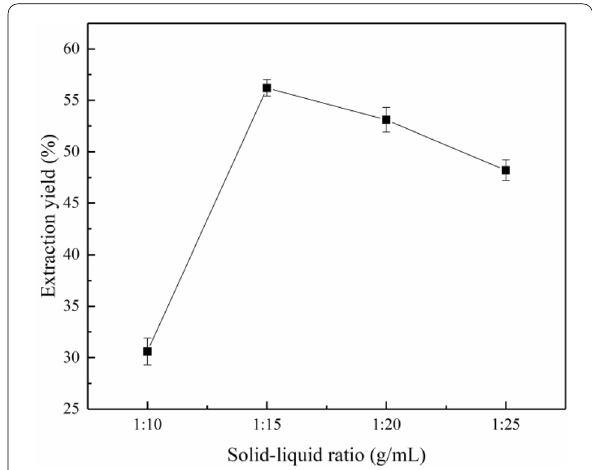
Fig. 5 Effect of the solid/liquid ratio on the yield of lignin extracted under the conditions of a reaction time of 120 min, extraction temperature of 170 °C, and ethanol concentration of 70%